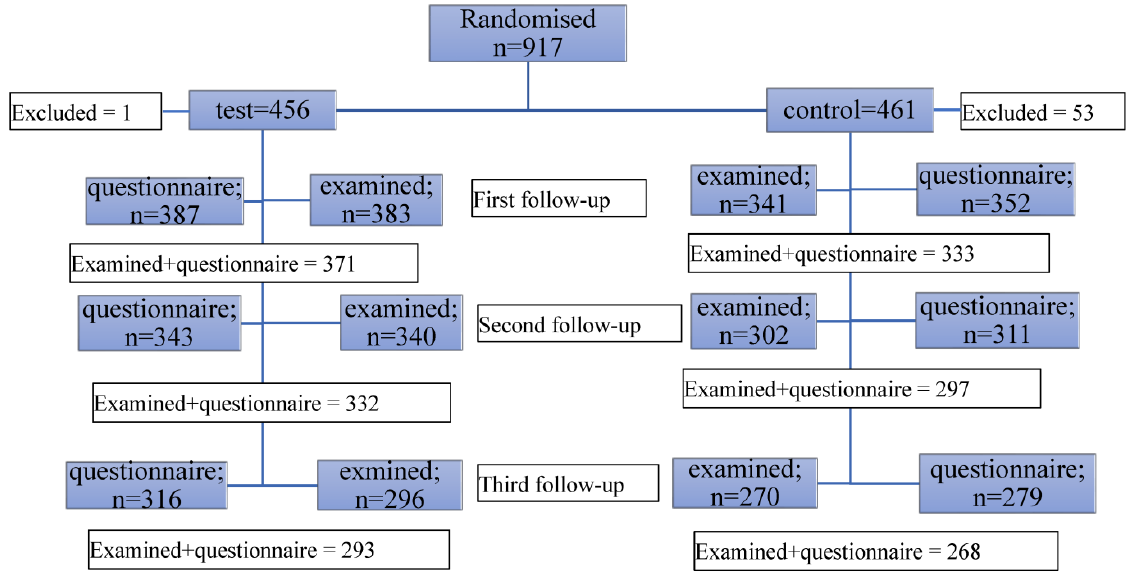
Figure 1. Participant